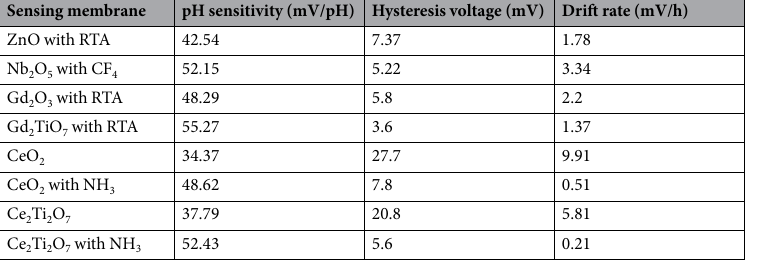
Table 1. Comparison with pH sensing devices composed of various membranes with different treatments. (RTA: rapid thermal annealing. CF 4 : CF 4 plasma treatment. NH 3 : NH 3 plasma